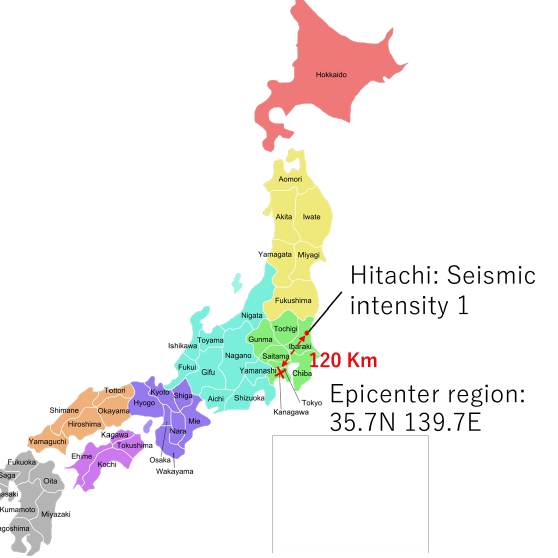
Figure 13. The maximum seismic intensity in Hitachi and the distance between Hitachi and the epicenter region, 23 wards,